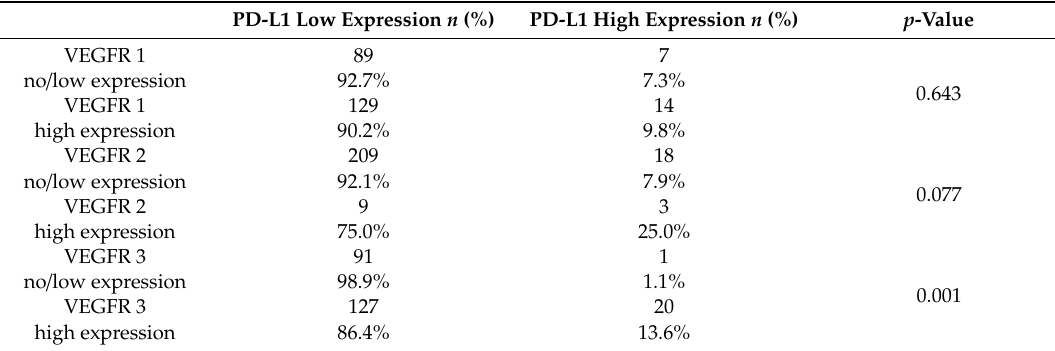
Table 4. Correlation of VEGFR 1-3 and PD-L1 (programmed death ligand-1).